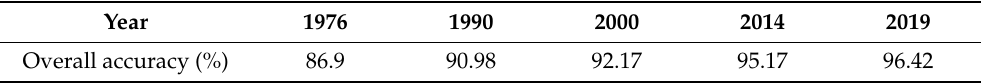
Figure 3. The spatial distributions of land cover types in the GBA from 1976 to 2019. Table 4. Overall accuracy of the land cover classifications in the GBA from 1976 to